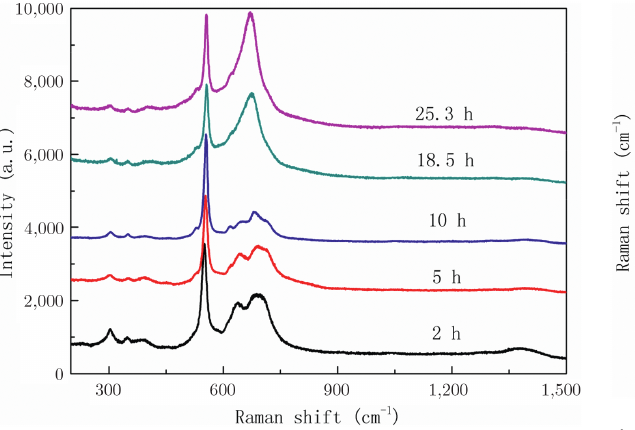
Figure 8: Raman spectra of stainless steel 441 oxidized for different times at 1,000°C in air with 11.5 vol.% H 2 O.